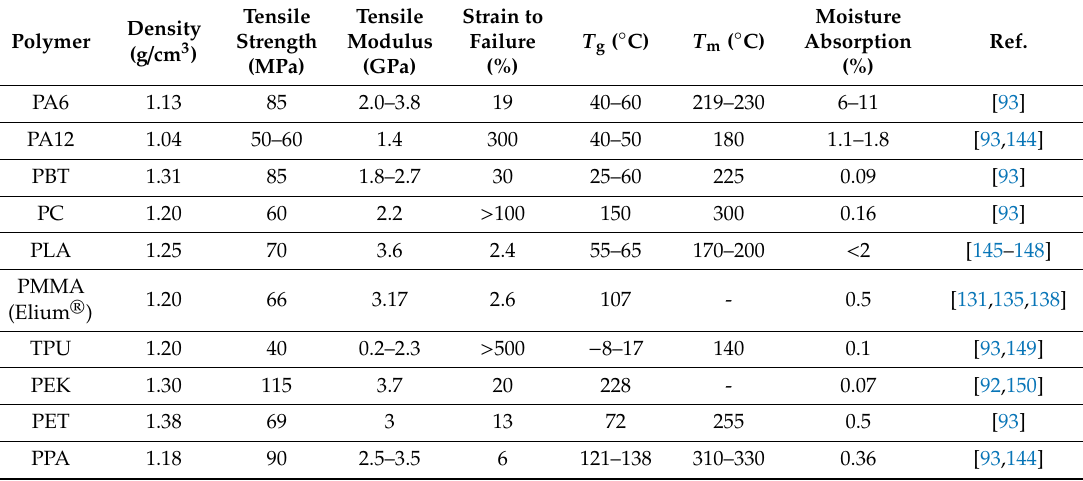
Table 3. Overview of properties of monomer-infusible thermoplastic